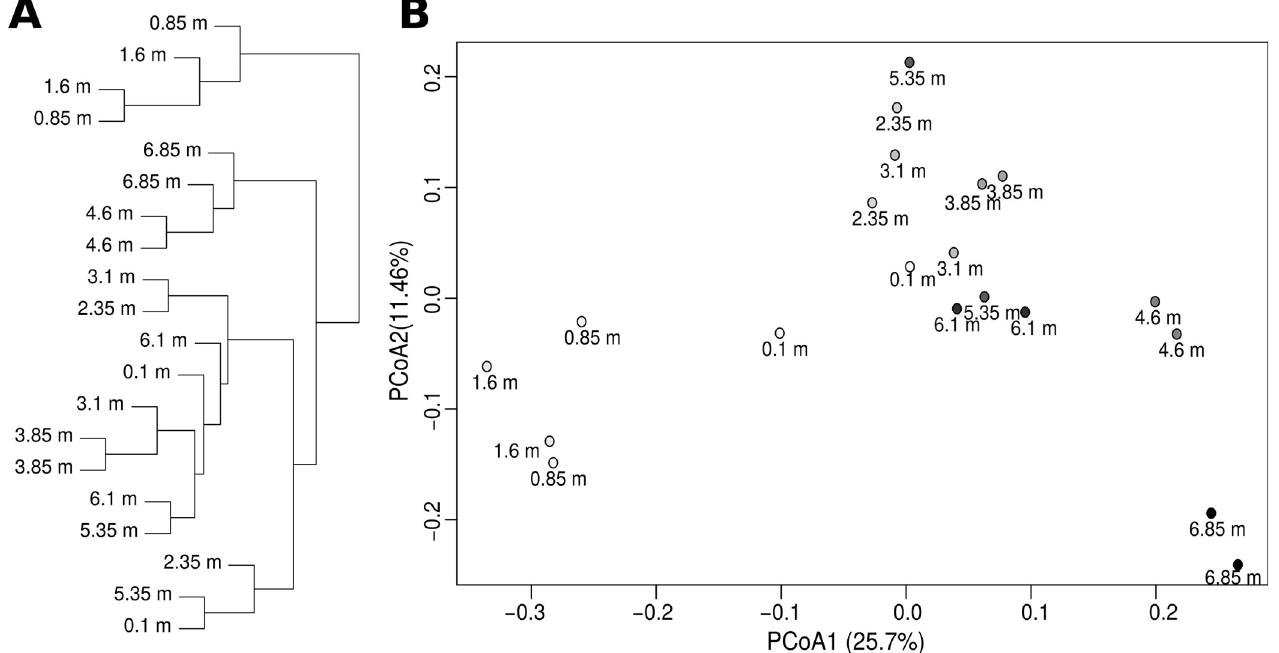
Fig 4. Clustering analyses performed based on Bray-Curtis dissimilarity distances of prokaryotic OTU sequence abundance. (A) A hierarchical cluster tree; and (B) principal coordinate analysis (PCoA) scatter plot. PCoA1 and PCoA2 explained 25.7% and 11.46% of the observed variation. Black and grey- colored circles indicate the depth of the microbial